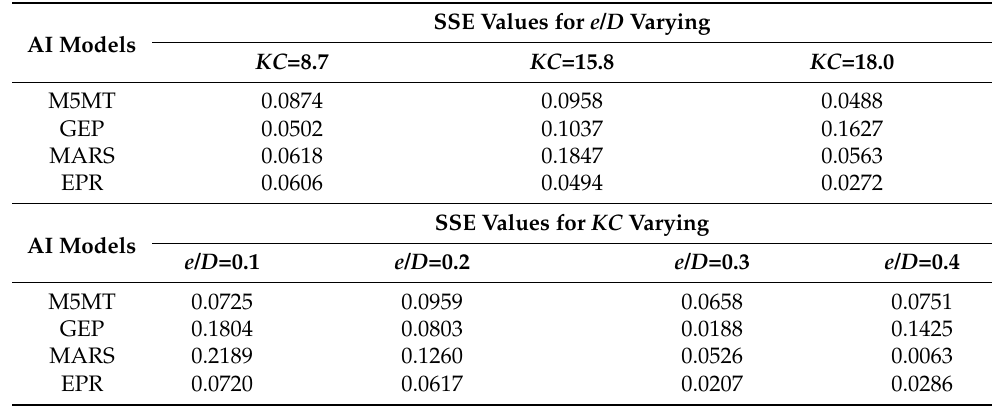
Table 7. SSE values for the considered AI models when predicting V ∗ KC